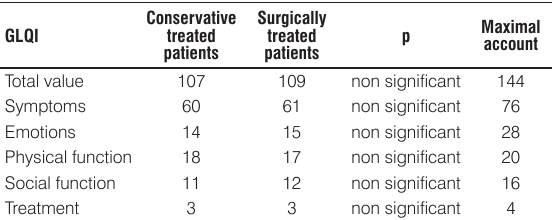
Table 3. Gastrointestinal Quality of Life Index by conservatively and surgically treated patients.